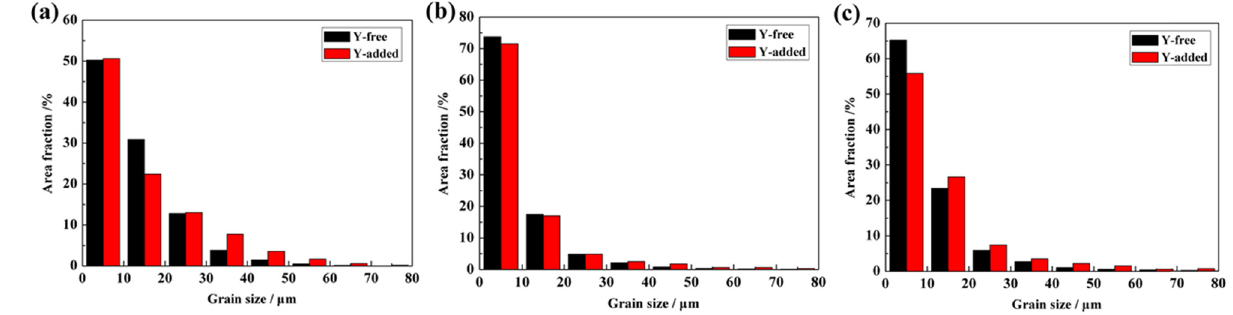
Figure 10: Grain size at di ff erent thicknesses of Y - free and Y - bearing hot - rolled sheets: ( a ) S = 0; ( b ) S = 1/4; and ( c ) S =